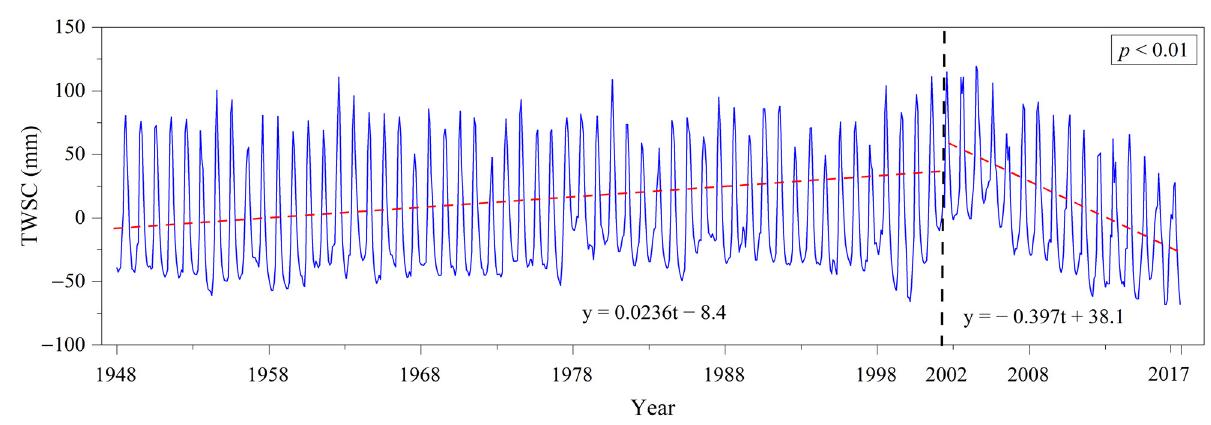
Figure 5. Monthly variation of TWSC in the YZRB from 1948 to 2017. The vertical dashed line represents the dividing year of 2002.